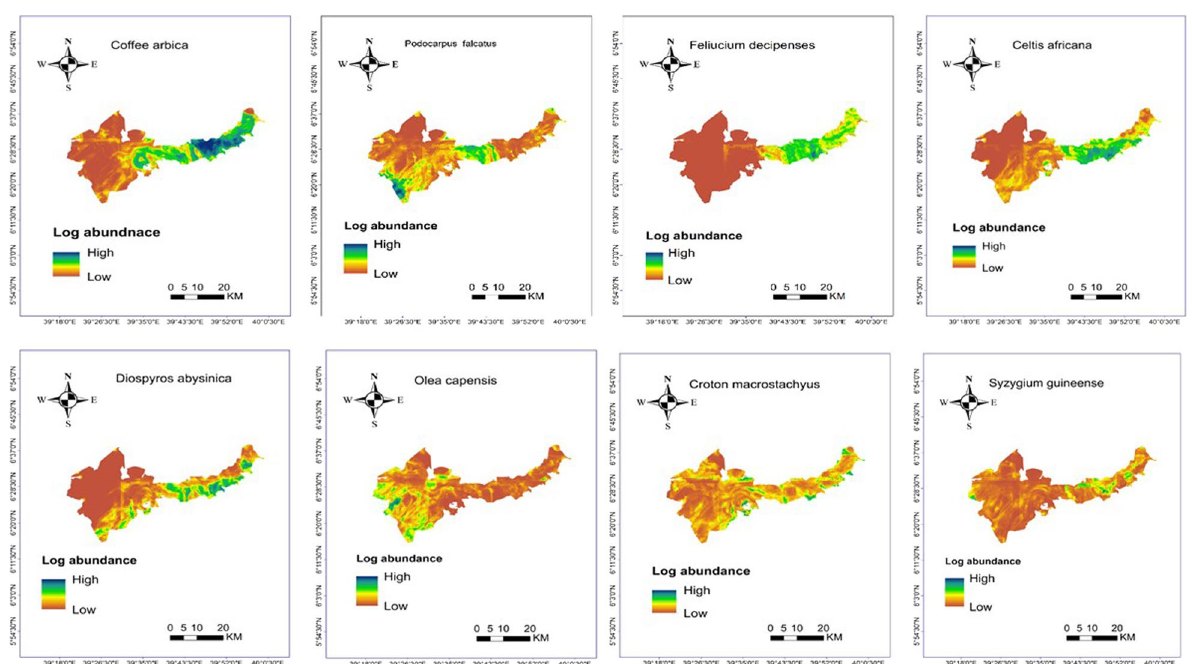
Fig. 3 Spatial distribution maps produced by the RF model of the log abundances of the eight woody